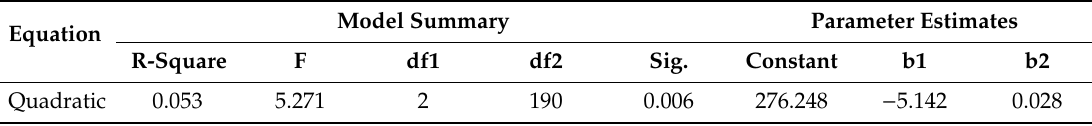
Table 3. Regression curve estimation.